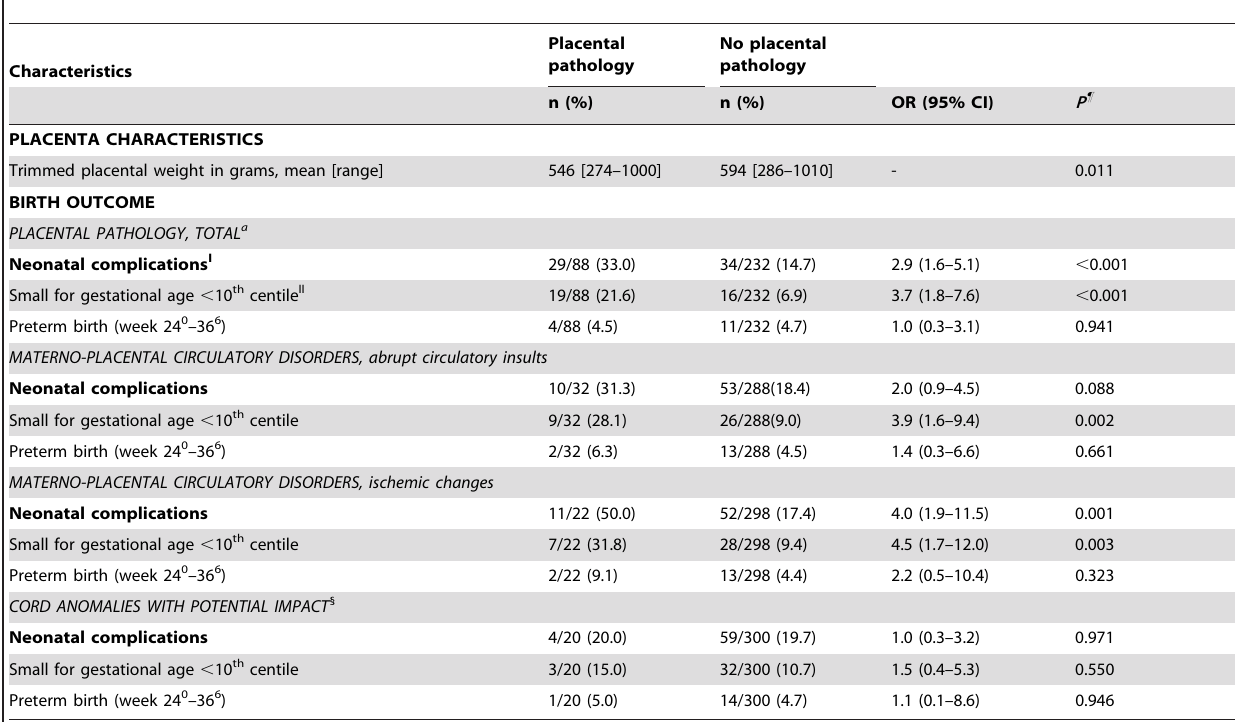
Table 5. Placental pathology by birth outcome (n=